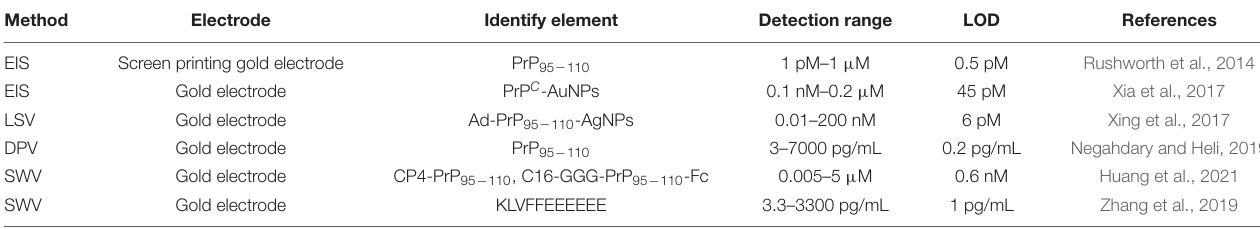
TABLE 1 | Electrochemical biosensor based on A β